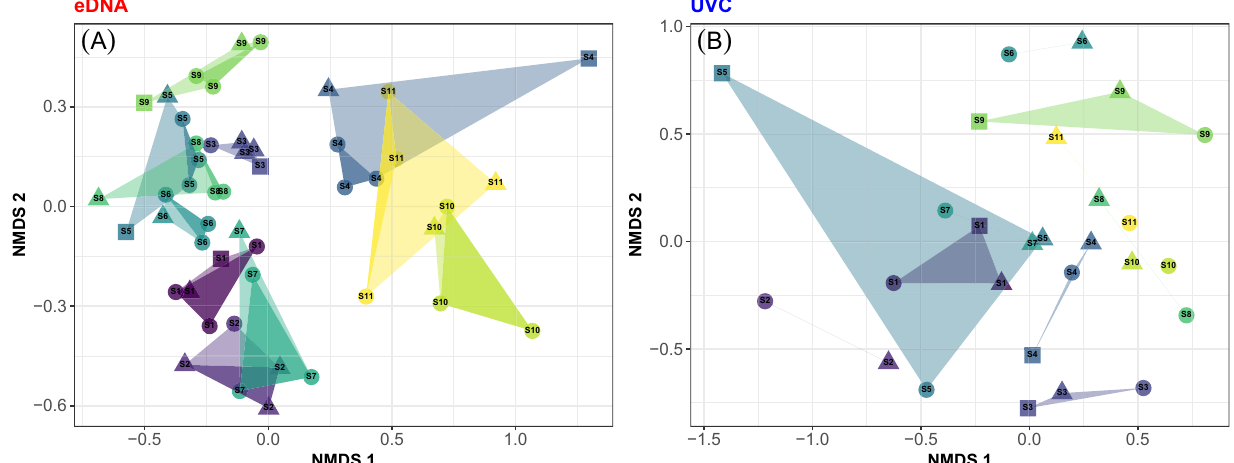
Figure 5. Spatial variation in community structure among samples based on Non-Metric Multidimensional Scaling (NMDS) ordinations for eDNA ( A ) and UVC ( B ). Samples are colored by site (light colored hulls) and triplicate water samples (in A ) are colored using darker hulls. Transects within sites are represented using different symbols. S1 to S11 indicates site number. Color code is as in Fig. 1. Ordination are based on Bray– Curtis dissimilarities of the square root number of reads ( A ) and observed biomass ( B ) of fish taxa. Taxa scores are showed in Supplementary Fig. SM6.